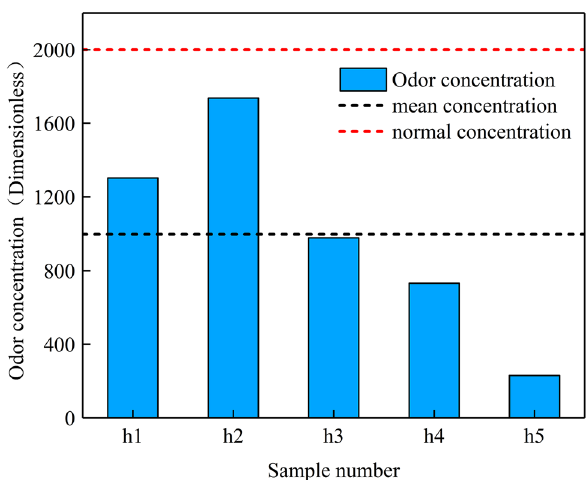
Fig. 3 The level of odor emissions of cremators